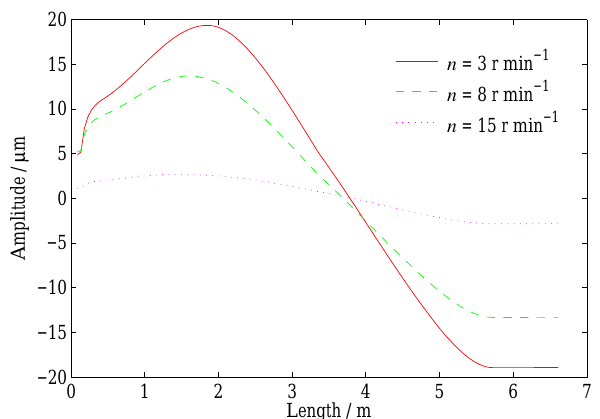
Figure 18. Effect of the drum’s tilt angle on vibration amplitude.